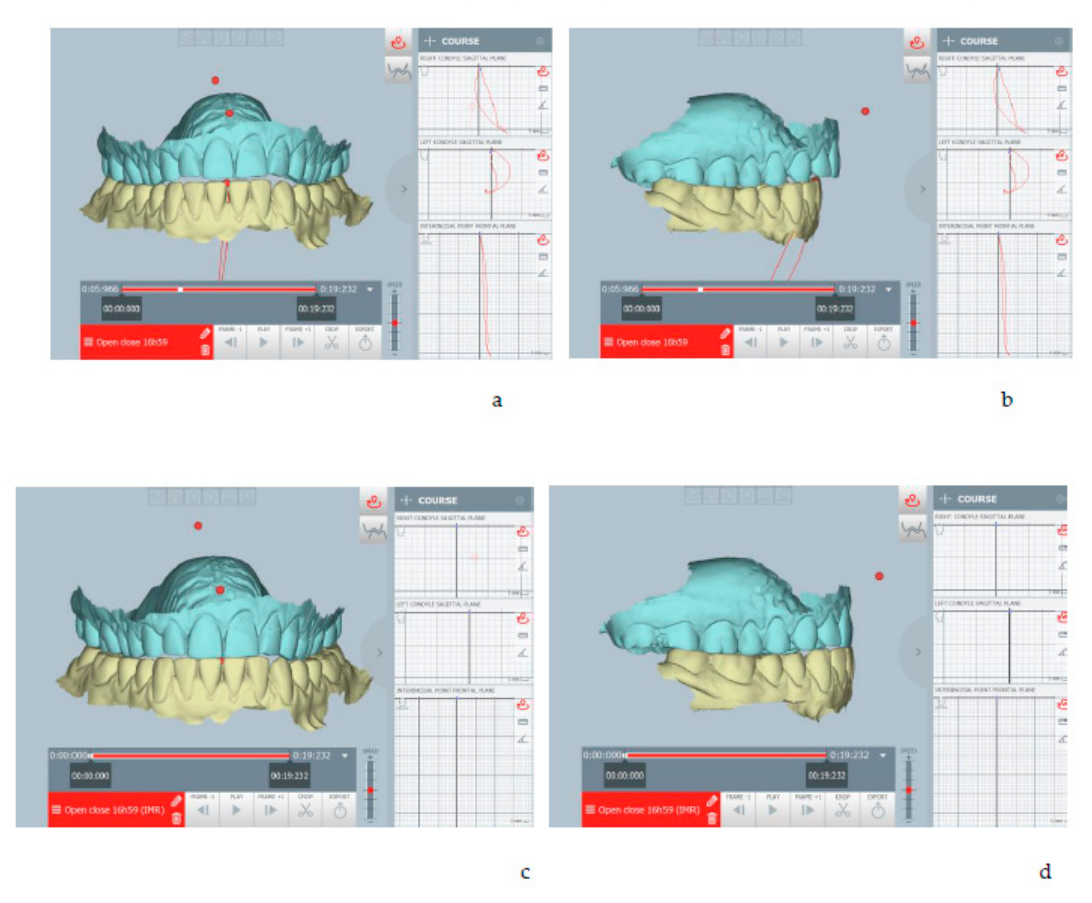
Figure 9. ( a , b ) The habitual occlusion position, and ( c , d ) the therapeutic position obtained after digital planning, repositioning the condyles forward and downward, and re-centering the midline. The therapeutic position was planned in real time during the patient’s diagnostic checkup (one-day full-digital